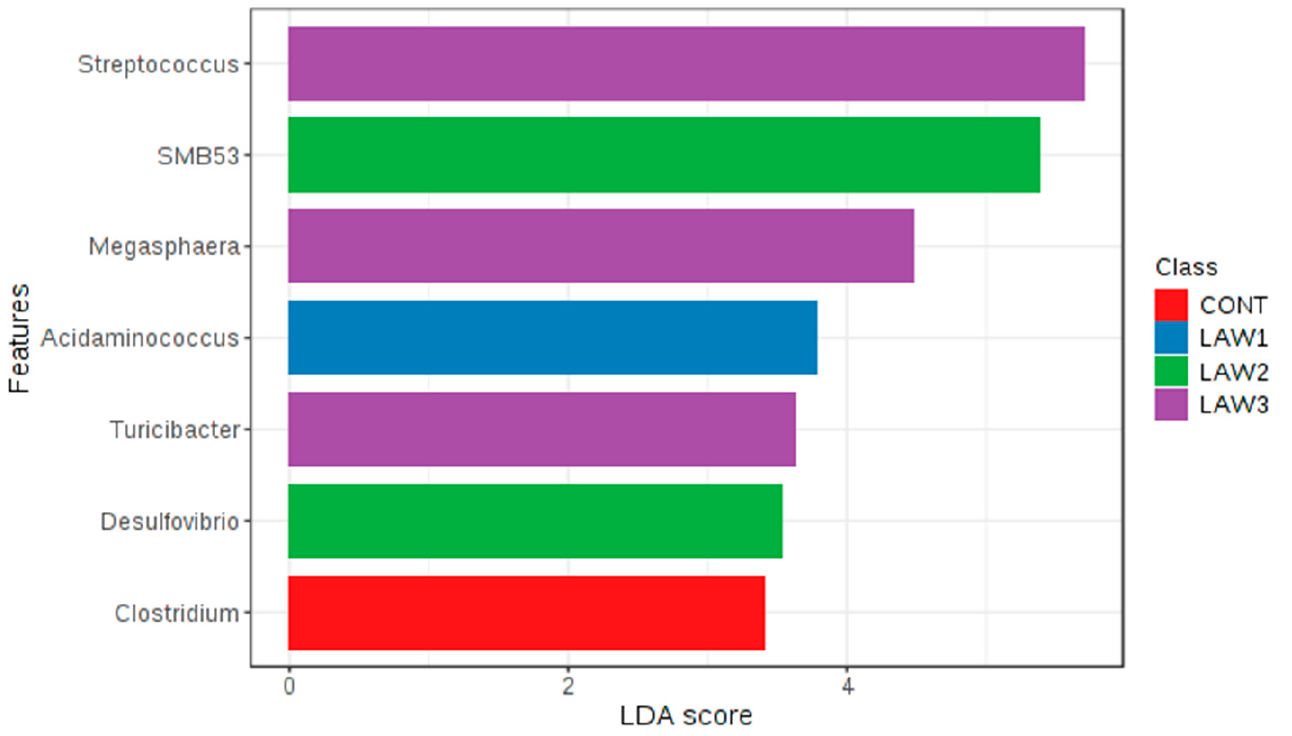
Figure 7. Differentially abundant genera in the pig gut microbiota among the four treatment groups orally vaccinated with Lawsonia intracellularis vaccine at week 6. The linear discriminant analysis (LDA) effect size (LEfSe) algorithm is used for biomarker discovery, which emphasizes both statistical and biological relevance. A p -Value of <0.05 is considered significant in Kruskal–Wallis and pairwise Wilcoxon tests, respectively. The LDA score for discriminative features is 3. The length of the histogram represents the LDA score, which explains the degree of influence of species with significant difference among the four treatment groups (CONT, LAW1, LAW2, and LAW3).